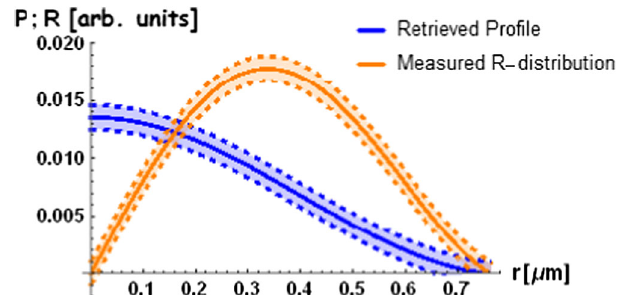
FIG. 3. Electron energy spectrum relative to the electron bunch accelerated in the bubble regime. Central energy γ 0 ¼ 320 MeV, energy spread 2 σ γ = γ 0 ∼ 20% . The outlines of the energy spec- trum (up) and of the beam divergence (right) are reported.